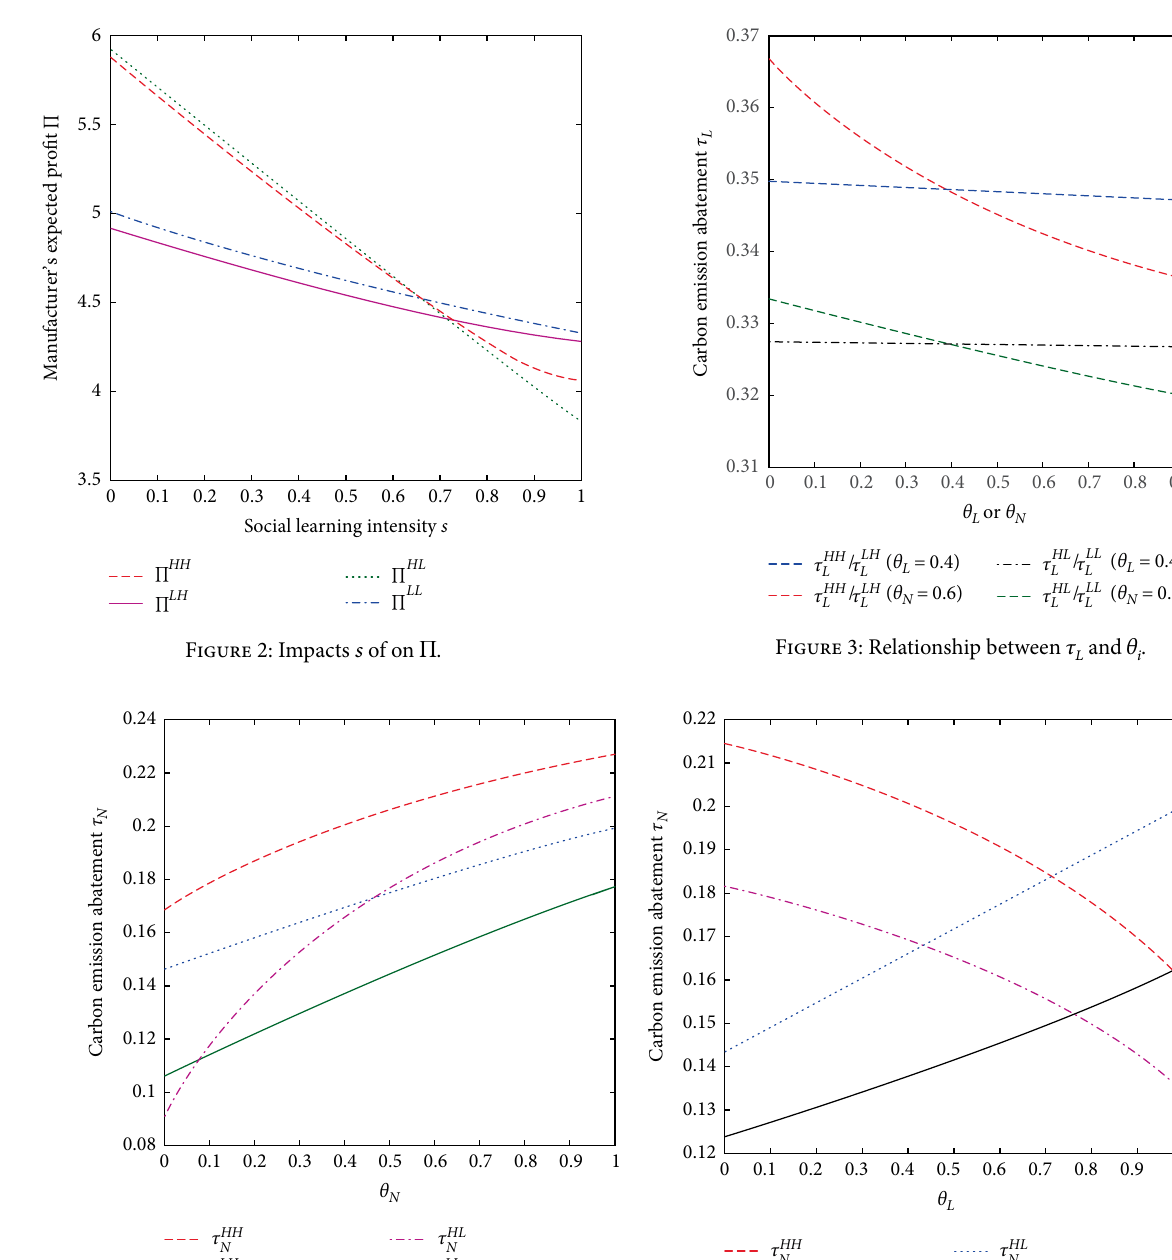
on 𝜏 , (b) impact of 𝜃 𝑁 𝑁